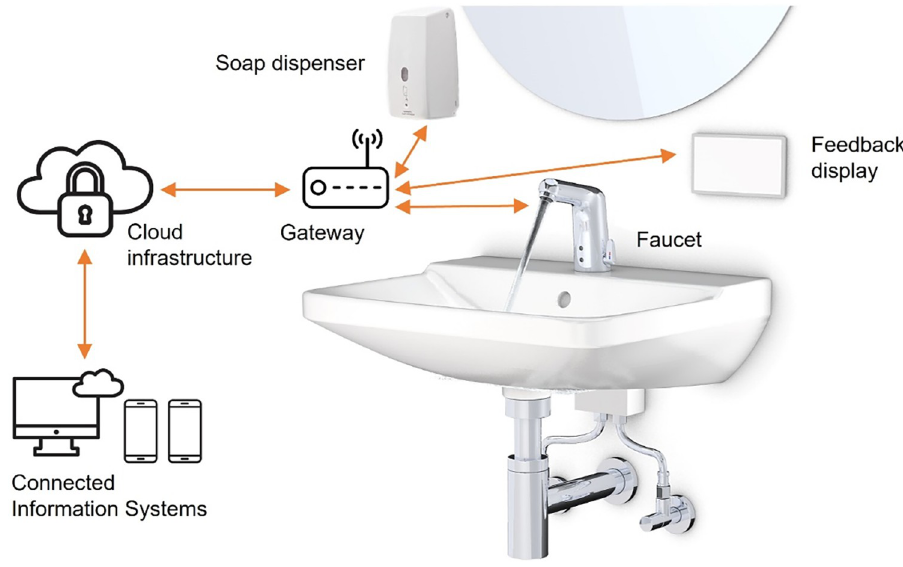
Fig 5. Technical setup of the